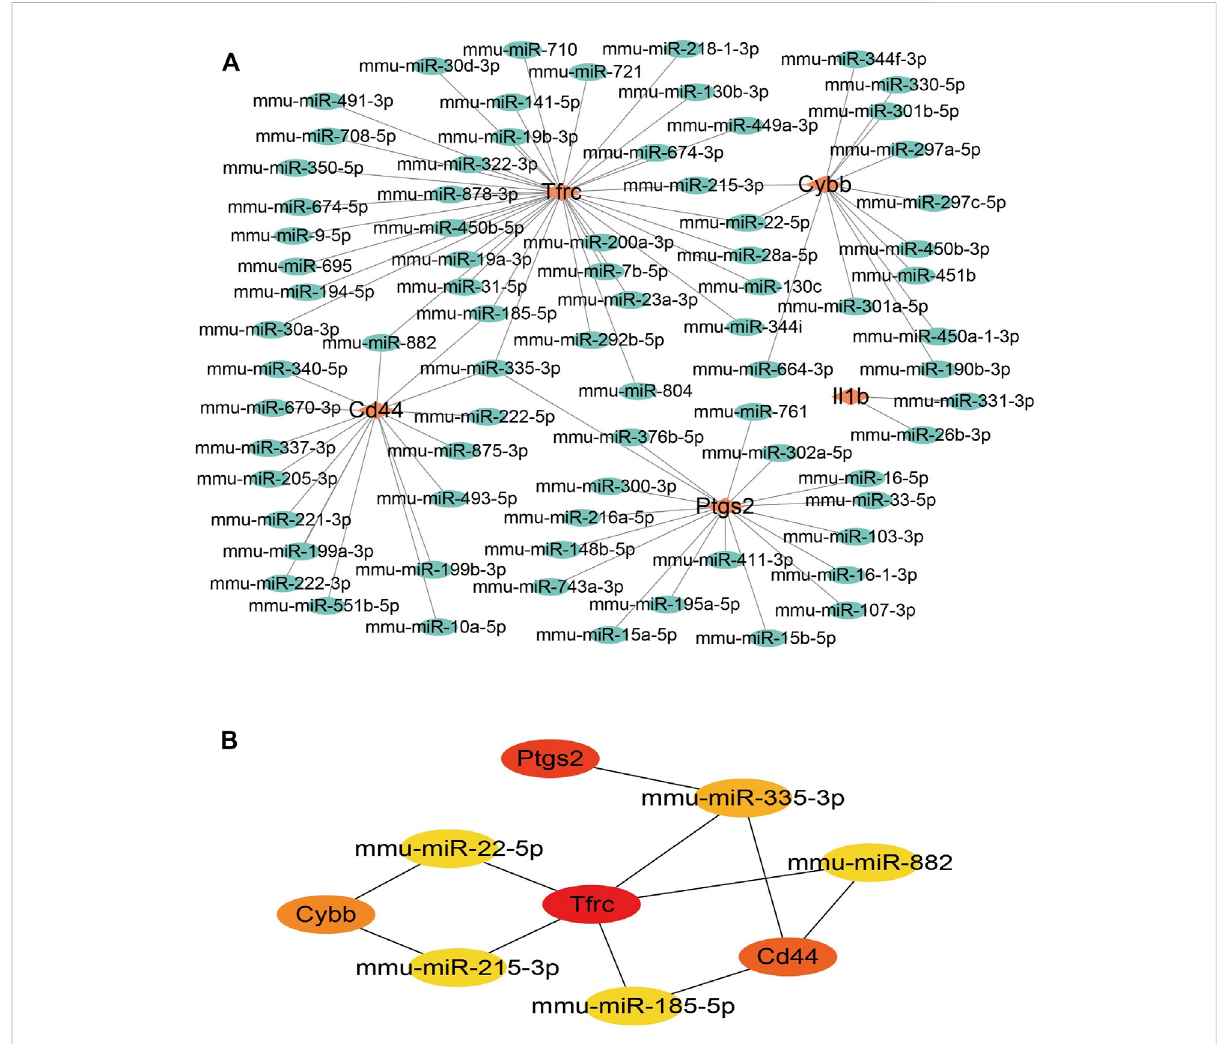
FIGURE 5 miRNA-mRNA network construction of hub genes. (A) miRNA-mRNA network construction. (B) The hub genes in the miRNA-mRNA